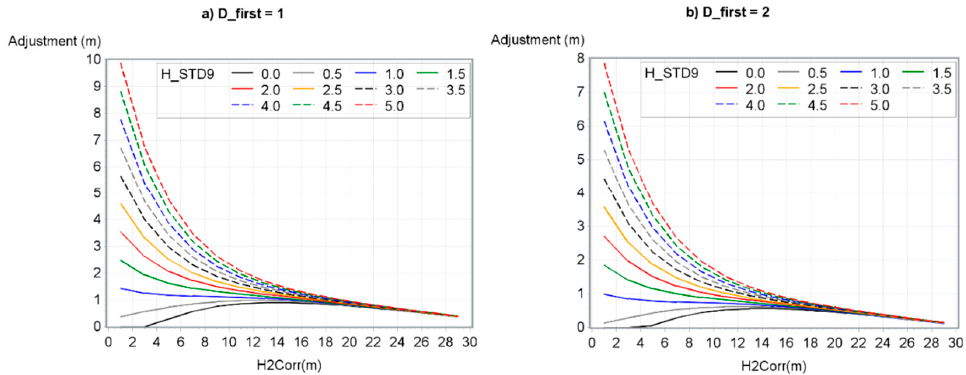
Table 6. Random coefficients ( δ m ) of height adjustment model for